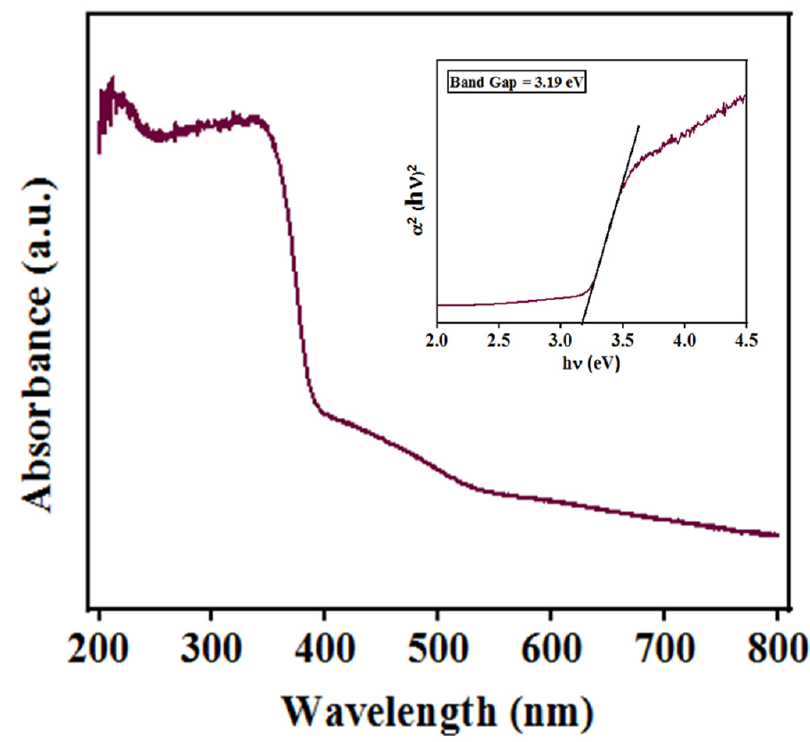
Figure 6. Absorbance vs. wavelength plot showing band gap (Tauc’s plot inset). Under individual and coupled catalytic conditions, the contribution of photocatalytic and piezoelectric properties to degradation was assessed as follows: photocatalysis, piezo- catalysis, and piezo-photocatalysis through both unpoled and unpoled BST-BZT powder. In the present study, methylene blue (MB) dye has been selected as an indicative organic pollutant in water. For the assessment of MB dye degradation through photocatalysis, piezocatalysis, and piezo-photocatalysis processes, initially, 0.1 g of BST-BZT powder was immersed in 10 mL of ~5mg/L concentrated MB dye overnight. This was performed to attain an adsorption–desorption equilibrium between the catalyst (BST-BZT composition) and MB dye. Once the adsorption–desorption equilibrium was attained, the BST-BZT powder was subjected to a visible light source, vibrations, and visible light plus vibrations to quantify the weakening of the MB dye. The dye-containing BST-BZT composition was stirred using a magnetic stirrer while placing it in a dark environment for distinguishing adsorption and catalytic processes. Figure 7a,b show the absorbance spectra of MB dye taken at an interval of 30 min and continuing up to 3 h using 0.1 g of both unpoled and poled BST-BZT samples through the photocatalysis